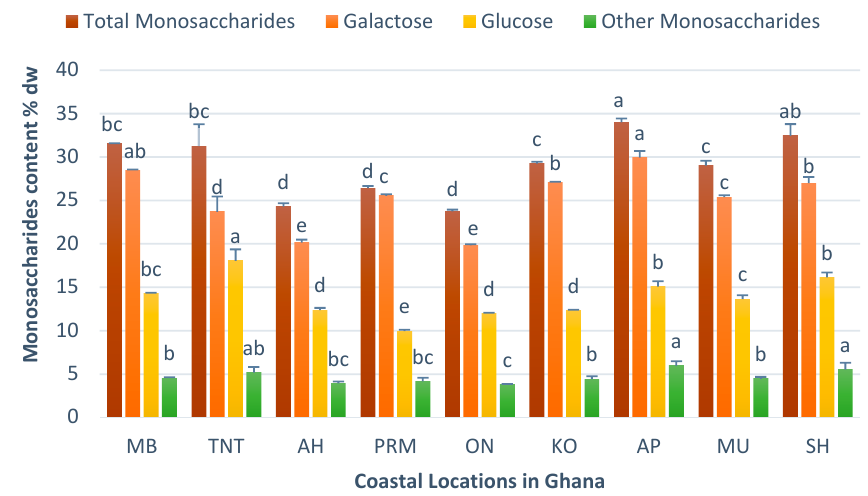
Figure 6. HPLC-PAD analysis of monosaccharide composition of H. musciformis from selected coastal areas in Ghana. All values are given as dehydrated monomers; other monosaccharides were detected in minor amounts including mannose, xylose and glucuronic acid. Means with different letters ( i.e. , a, b, c, d, and e) are significantly different, p < 0.05 (ANOVA, Tukey’s 95% confidence intervals).